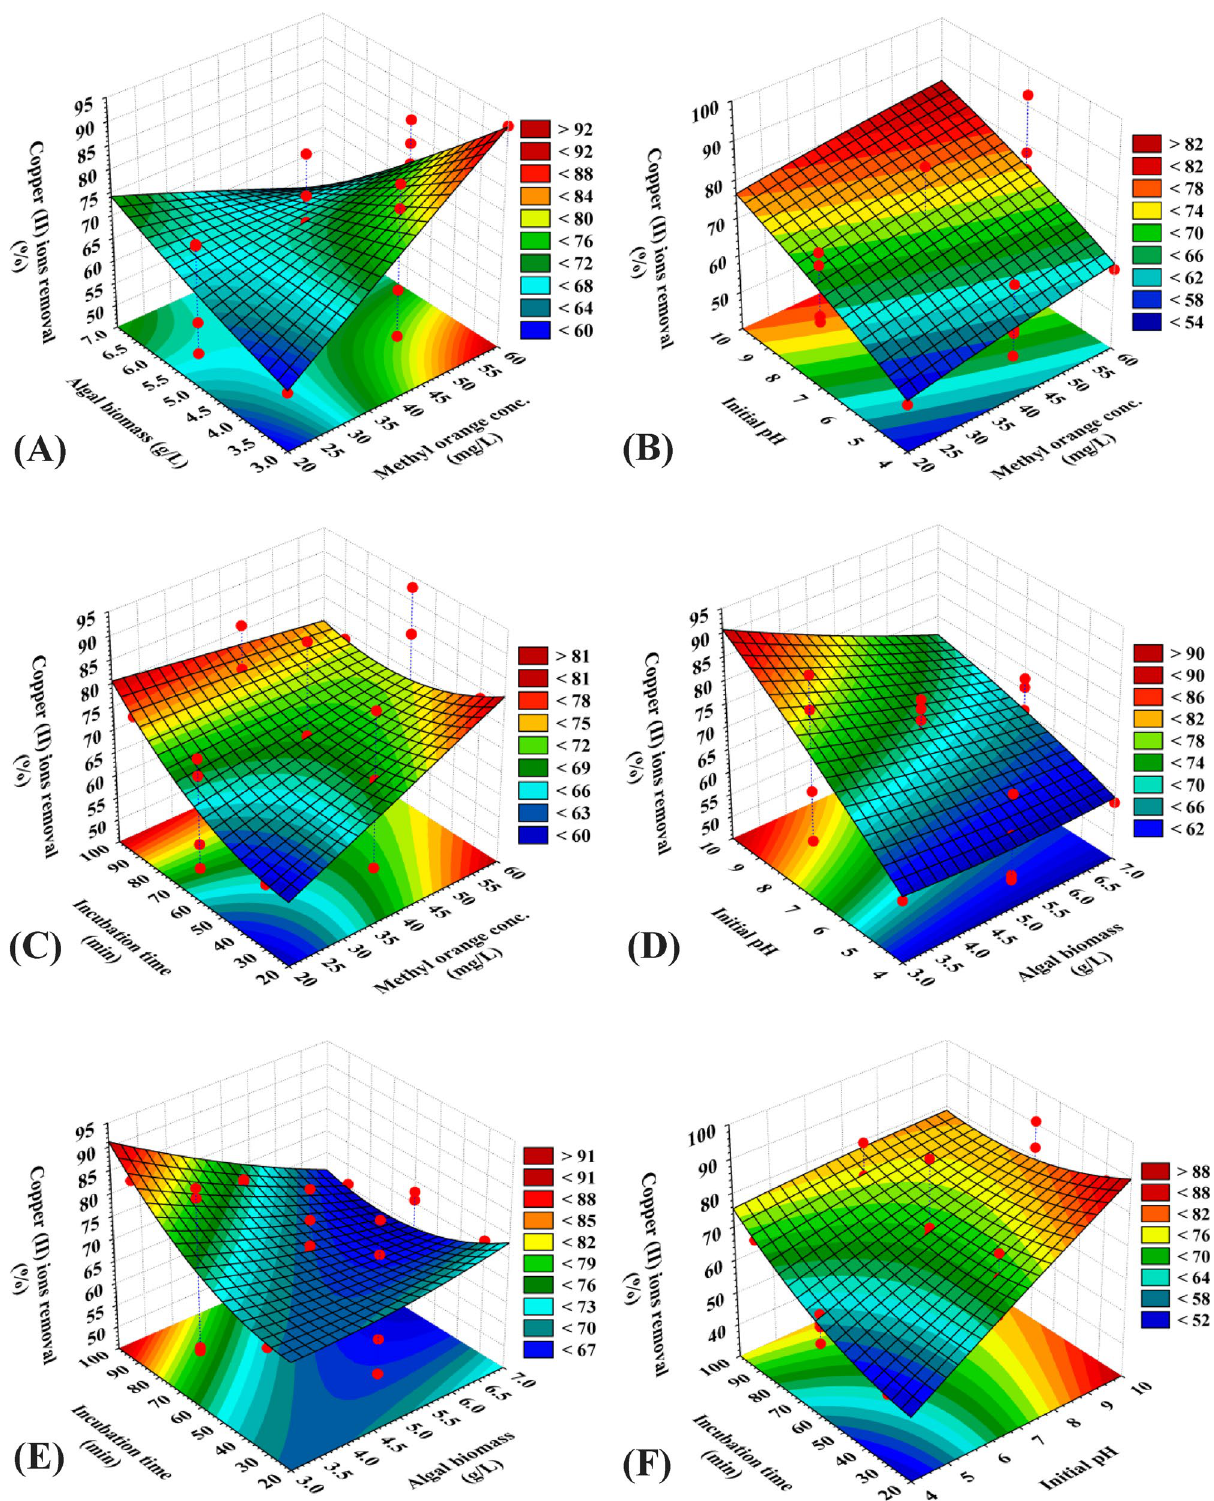
Figure 2. Three-dimensional surface plots of biosorption of copper (II) ions by Fucus vesiculosus biomass displaying the interactive effects of the four tested variables. This figure was created by using statistical software package, STATISTICA software (Version 8.0, StatSoft Inc., Tulsa,